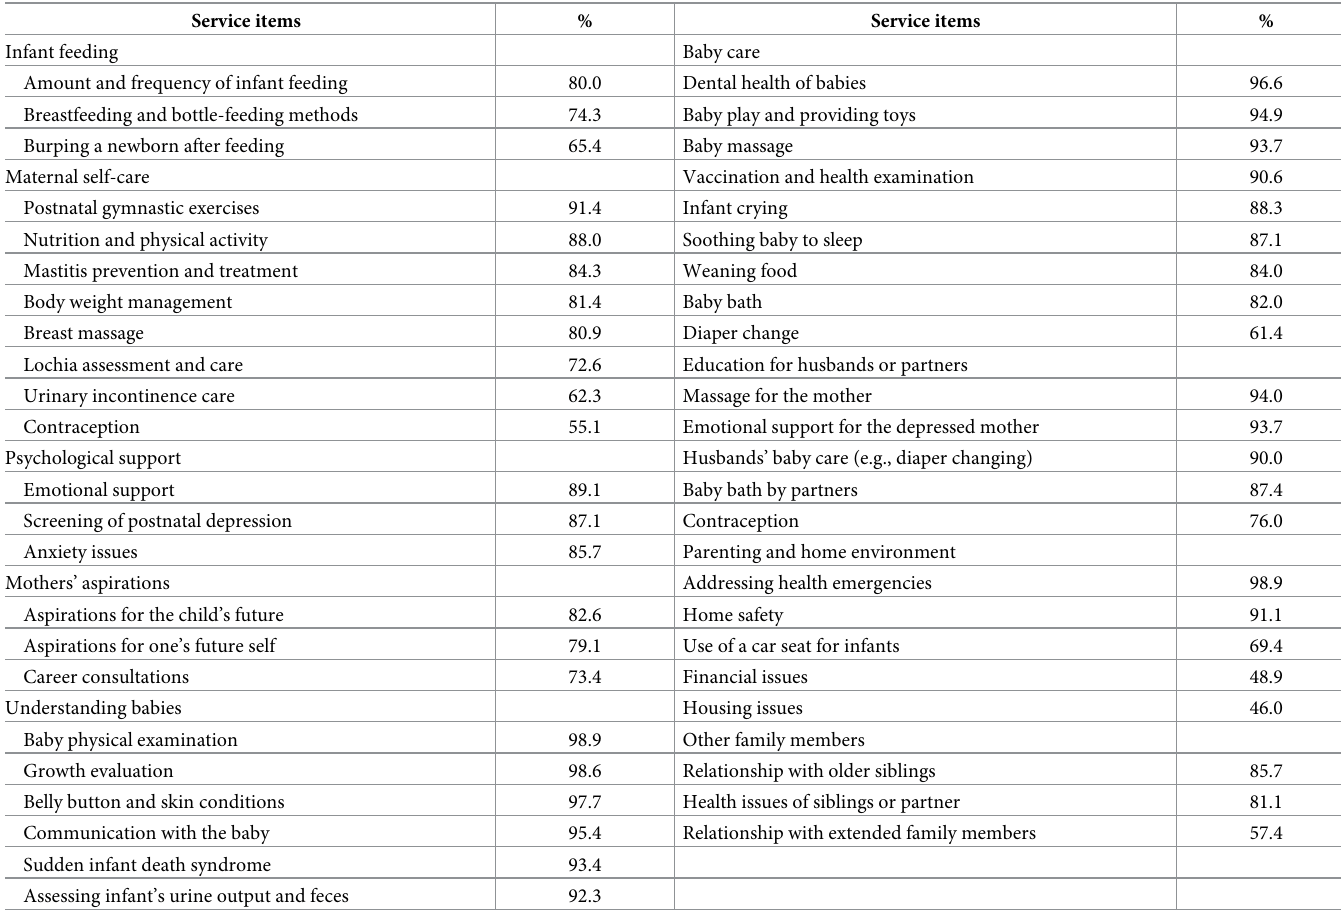
Table 5. Needs (%) for postnatal nurse home visitation services among pregnant women and women with children below the age of 24 months (N =